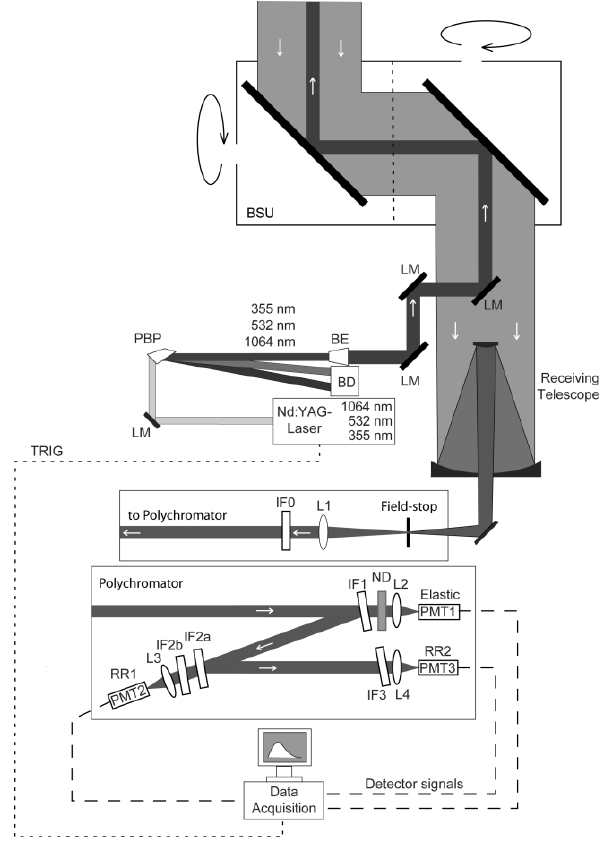
Figure 1. Scheme of the UHOH RRL. The beam-steering unit (BSU) consists of two plane mirrors which scan the laser beam and receiving telescope field-of-view. LM: laser mirror; PBP: Pellin– Broca prism; BE: beam expander; BD: beam dump; L1 to L4: lenses; IF0 to IF3: interference filters; PMT1 to PMT3: photomul- tiplier tubes; RR1 and RR2: rotational Raman channel 1 and 2, re- spectively. The beam splitter for the water vapor Raman channel between L1 and IF0 has been omitted for clarity